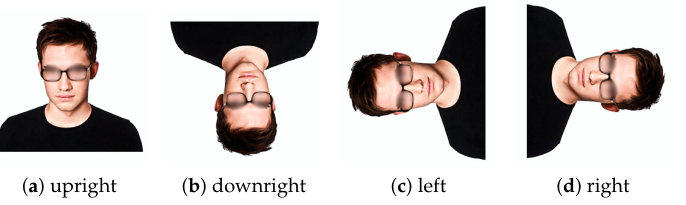
Figure 1. The definition of facial orientation: ( a ) upright at 0 ◦ ; ( b ) downright at − 180 ◦ ; ( c ) left at − 90 ◦ ; and ( d ) right at 90 ◦